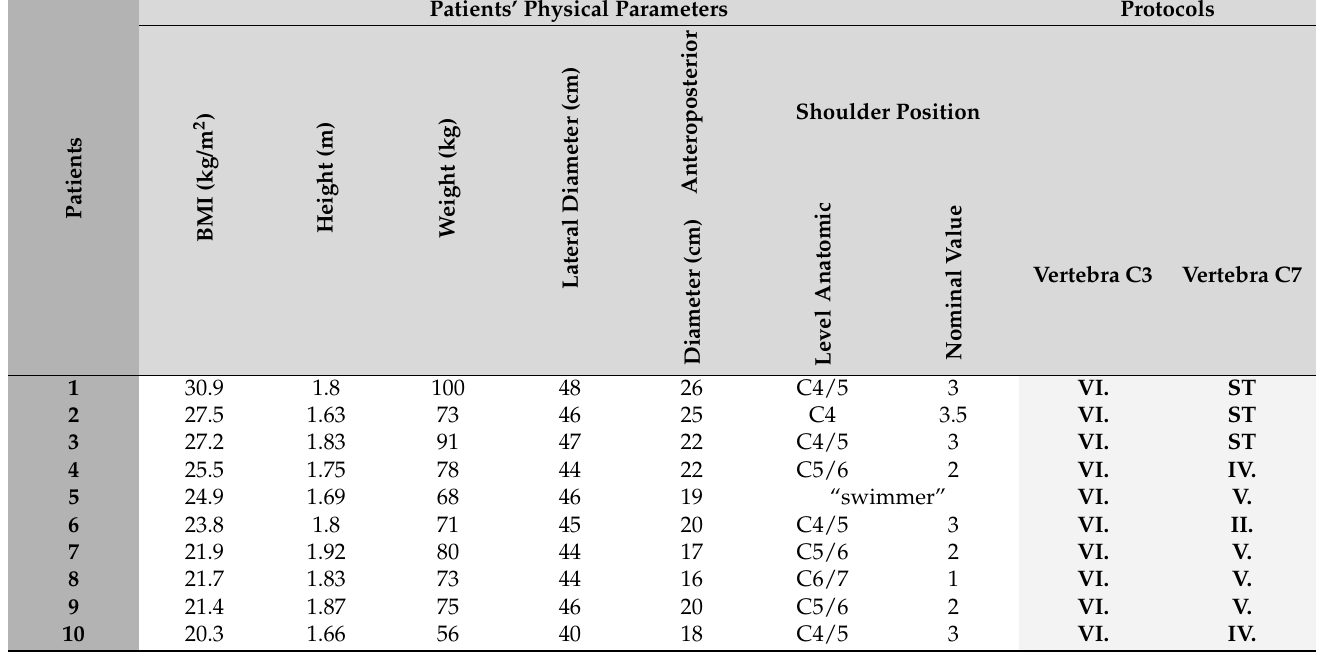
Table 3. Dose reduction for upper and lower c-spine and physical body parameters; the individual dose-reduced protocols allowing for diagnostic image quality for axial and sagittal reformations and the patients’ physical body parameters are detailed for each patient in this table.